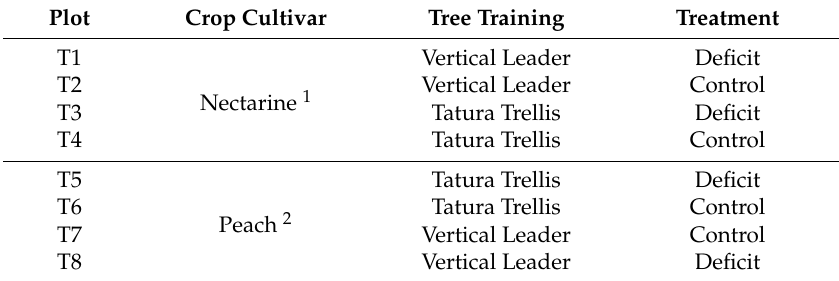
Table 1. Descriptions of sampled trees based on cultivar, training system, and irrigation treatment. Plot Crop Cultivar Tree Training Treatment T1 Vertical Leader Deficit T2 Vertical Leader Control Nectarine 1 T3 Tatura Trellis Deficit T4 Tatura Trellis Control T5 Tatura Trellis Deficit T6 Tatura Trellis Control Peach 2 T7 Vertical Leader Control T8 Vertical Leader